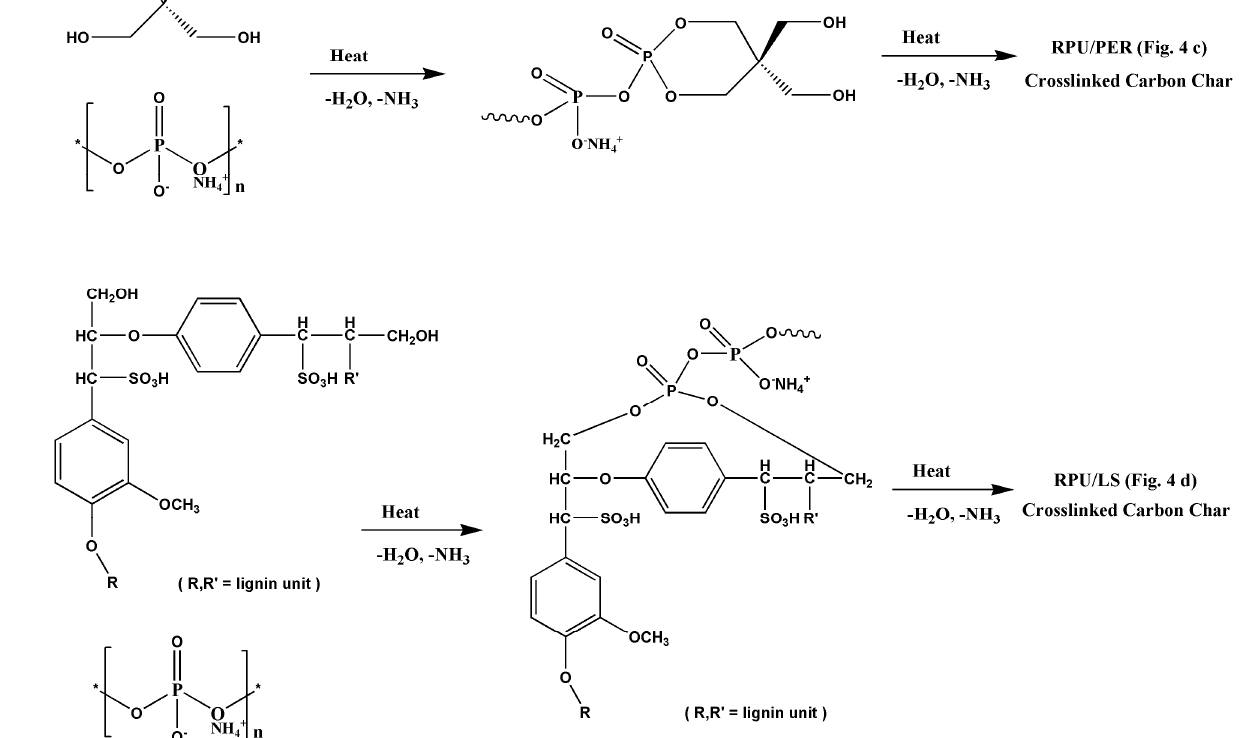
Figure 5. Flame retardant mechanism of PER/APP/MEL ( a ) and LS/APP/MEL ( b ) IFR formulation in RPU foam.